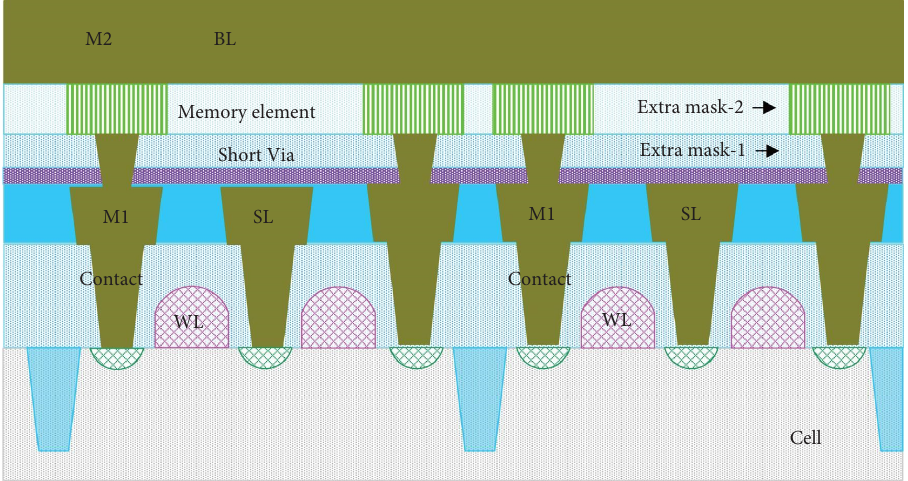
Figure 8: Te fabrication steps.